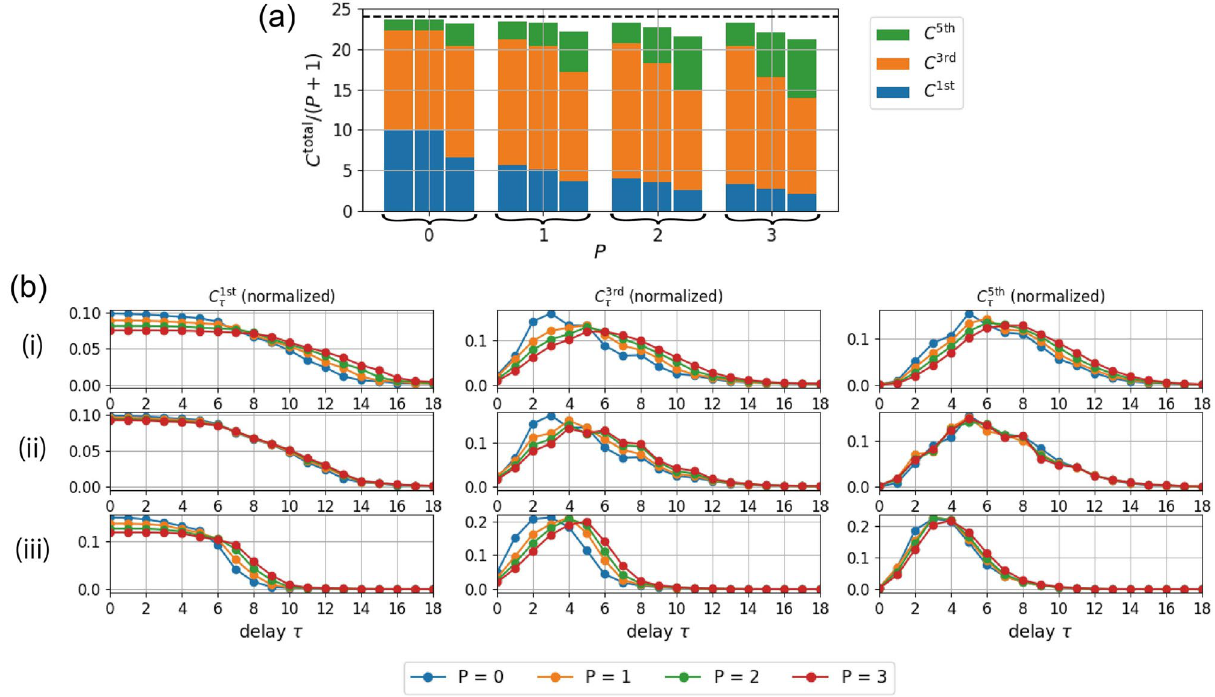
Figure 6. P -dependence of IPCs. ( a ) IPCs with the proposed methods for various values of P . Left columns: IPCs for delay-state concatenation, center columns: IPCs for drift-state concatenation, and right columns: IPCs for delay-state concatenation with one transient state. ( b ) Comparison of the delay structures of the IPCs for the three proposed methods. Top panels (i): delay structures for delay-state concatenation, middle panels (ii): delay structures for drift-state concatenation, and bottom panels (iii): delay structures for delay-state concatenation with one transient state. To highlight the difference in the distribution of the delay structures, the IPCs for each order are normalized. From left to right, the first-, third-, and fifth-order IPCs are shown. The parameters are set as follows: N res = 24 , ρ in = 0.9 , ρ res = 0.95 , and Q = 1